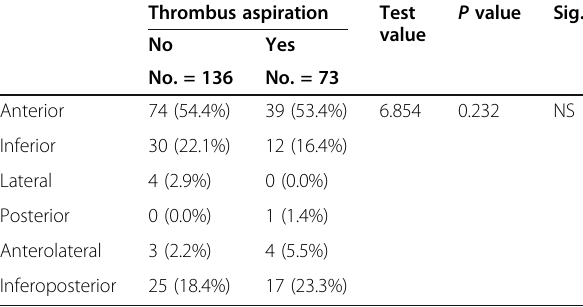
Table 2 Comparison between 2 groups regarding type of MI prevalent in each group